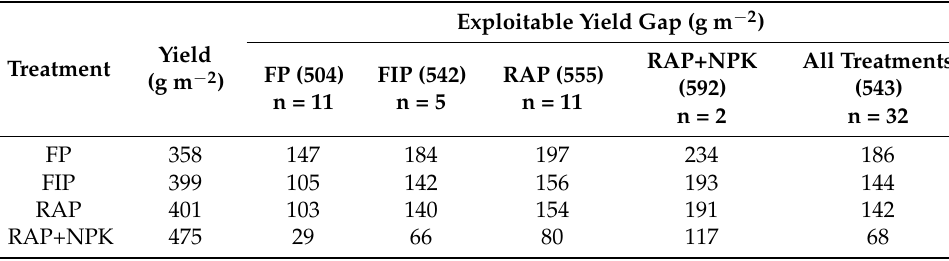
Table 3. Yields and exploitable yield gaps under different management levels (treatments), Doho